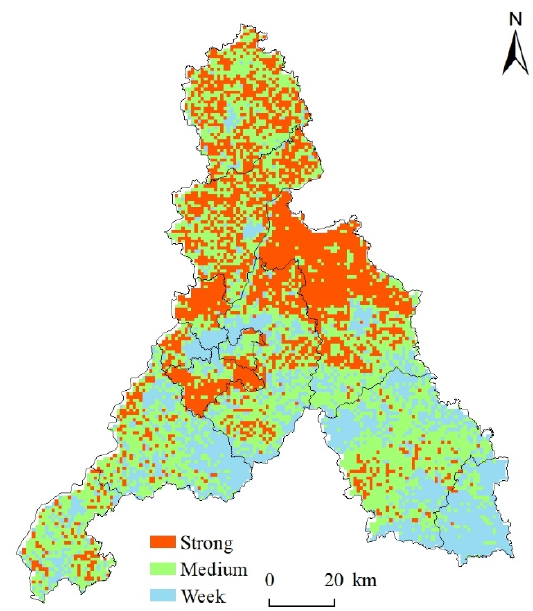
Figure 5. Spatial distribution of land use conflict.